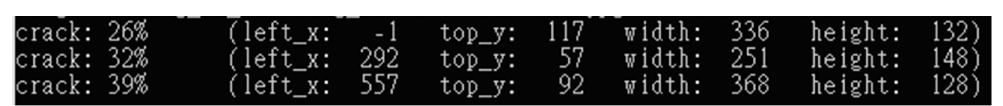
Figure 15. Bounding box cropping.